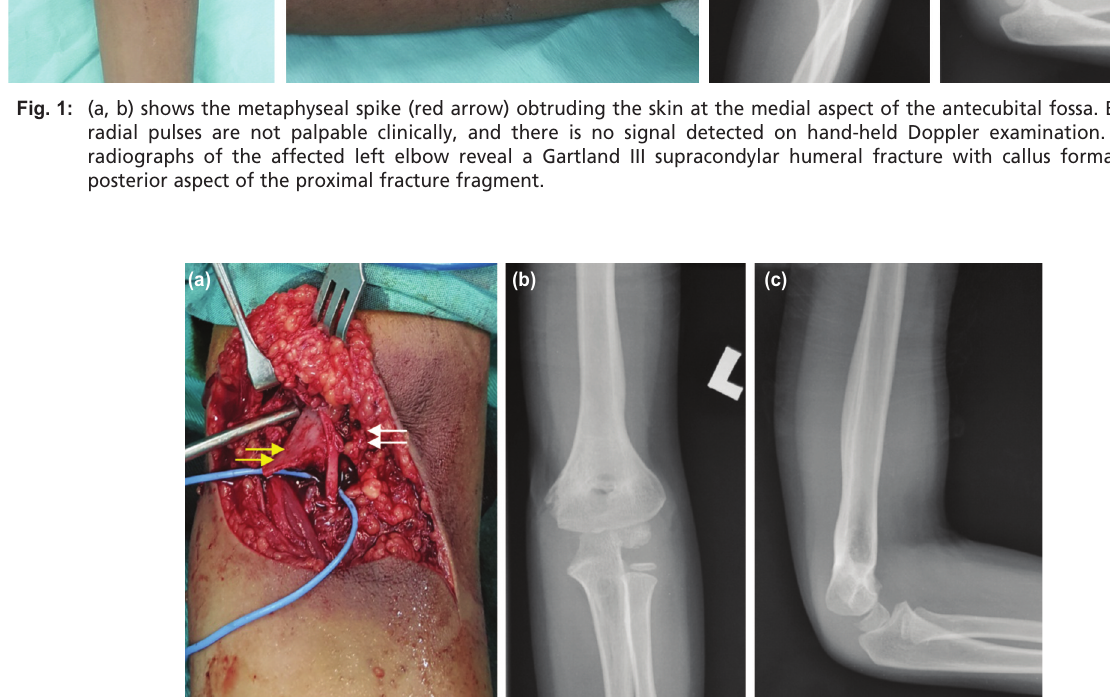
(a) Intra-operatively, the brachial artery is partially lacerated (white arrow) by the sharp edge of the metaphyseal spike (yellow Fig. 2: allow). The median nerve appears intact. (b, c) Radiographs of the left elbow (frontal and lateral projections) taken during a final assessment at one year post-operatively showed a well-united